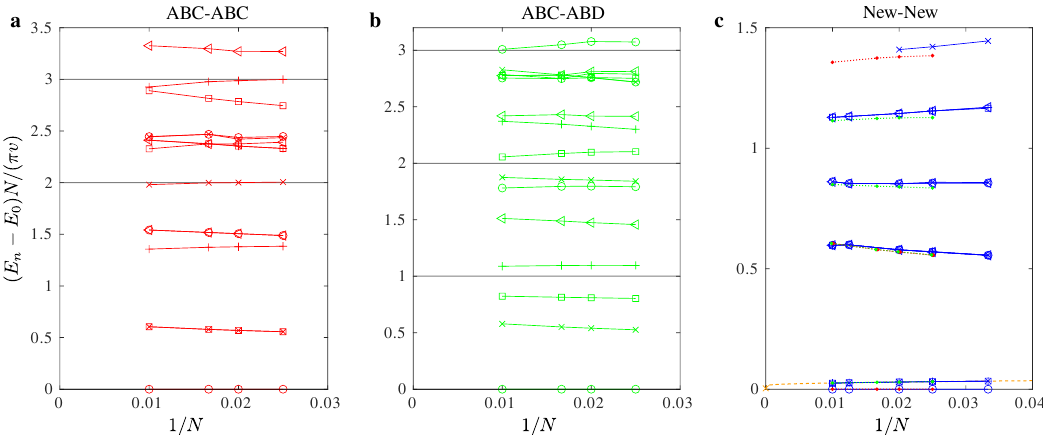
Figure 5: Conformal towers of states of the four-state Potts model with a three-state- mixed symmetric and b three-state-mixed non-symmetric boundary conditions, and c with symmetric boundaries polarized in the direction of the transverse field (follow- ing Ref. [ 24 ] we use the term "New" boundary conditions). Symbols are DMRG data points extracted from the low-lying energy excitation spectra with velocity v = π/ 4. Gray lines are integer levels shown for reference. In c the results from a (dotted red) and b (dotted green) are shown as a reference, the latter is shifted such that it starts at the first excites state of the New-New tower. Each level in New-New tower that matches a level of the ABC-ABD tower is three-fold degenerate. Orange dashed line is a finite-size extrapolation assuming log-corrections in the form derived by Cardy [ 45 ]